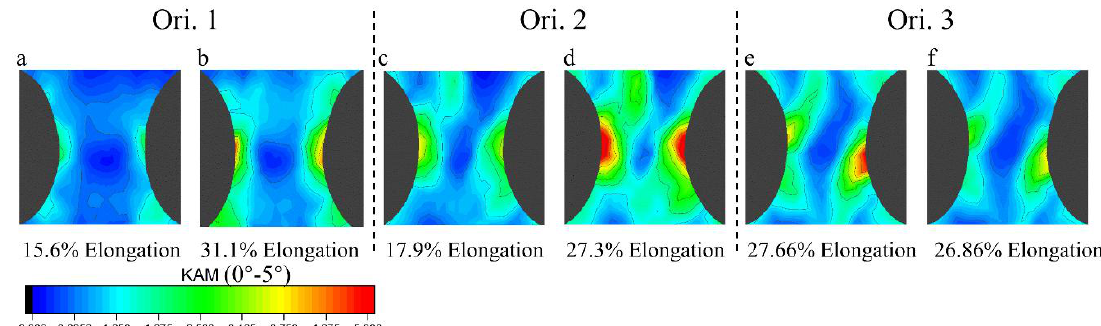
Figure 9. Kernel average misorientation maps derived from CP-FEM simulation after tensile deformation of ( a ) spe. 1-1; ( b ) spe. 1-2; ( c ) spe. 2-1; ( d ) spe. 2-2; ( e ) spe. 3-1; and ( f ) spe. 3-2. Dashed lines were used to separate specimens with different initial orientations.